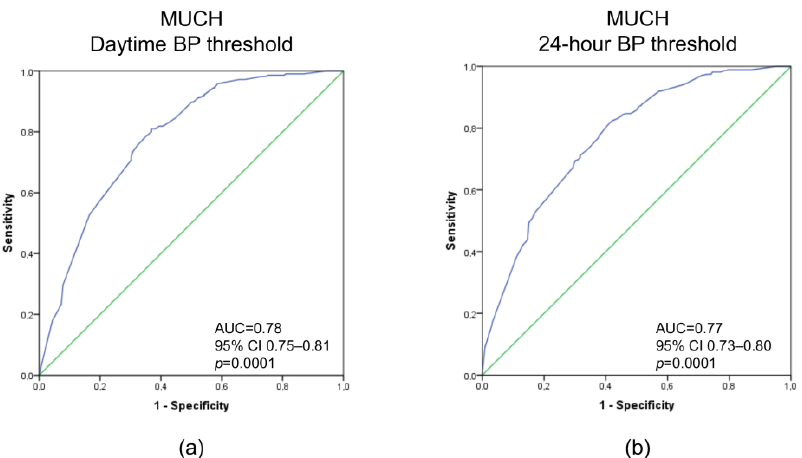
Figure 1. Receiver operating characteristic curves based on variables included in multivariate analyses in predicting masked uncontrolled hypertension defined by daytime blood pressure (BP) threshold ( a ), regardless of nighttime BP, and by 24 h BP threshold ( b ), regardless of daytime or nighttime BP. Abbreviations: AUC, area under the curve; CI, confidence